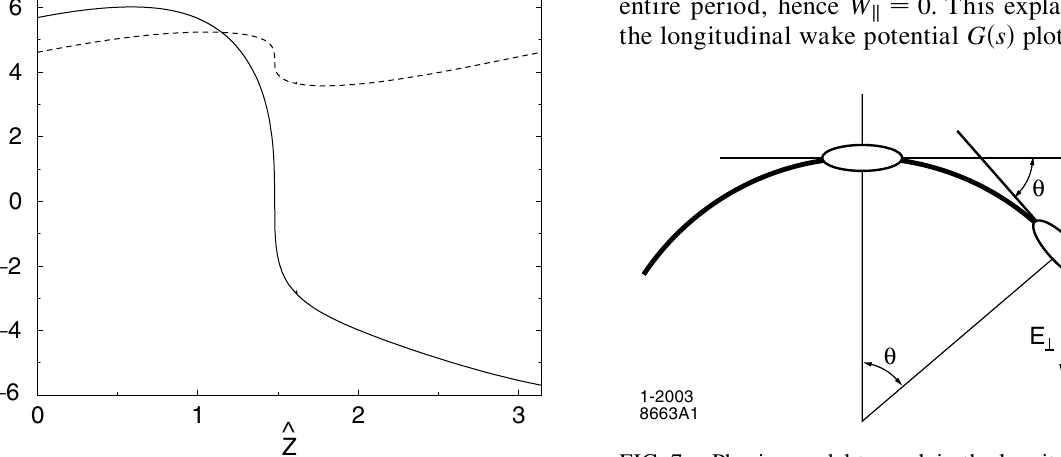
FIG. 7. Physics model to explain the longitudinal CSR wake. The two ellipses stand for a pair of electrons satisfying the retarded condition, i.e., the trailing electron is shown at the retarded time and the front electron at the test